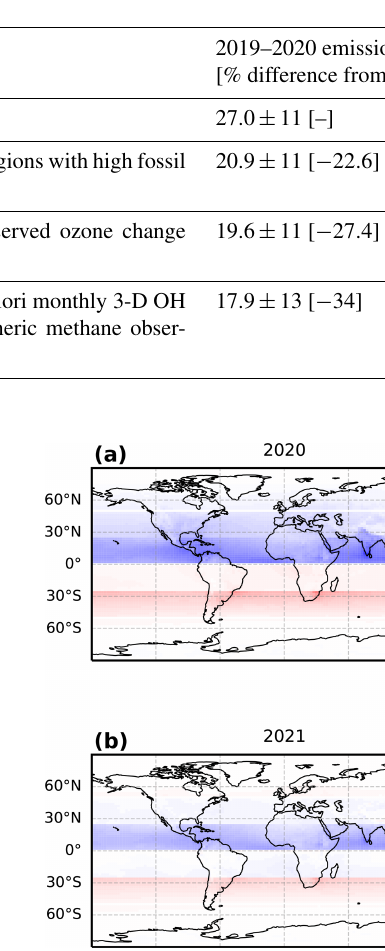
Table 2. Numerical experiments that explore the influence of assumed OH distributions on a posteriori methane emission estimates.